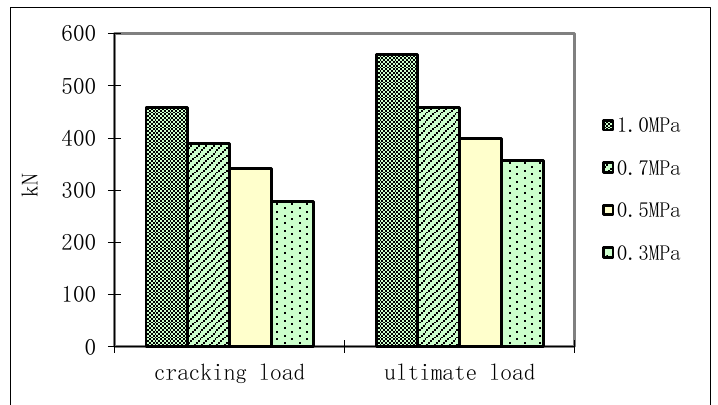
Figure 8. Comparison of the cracking load and ultimate load of walls with different thicknesses of insulating layers.